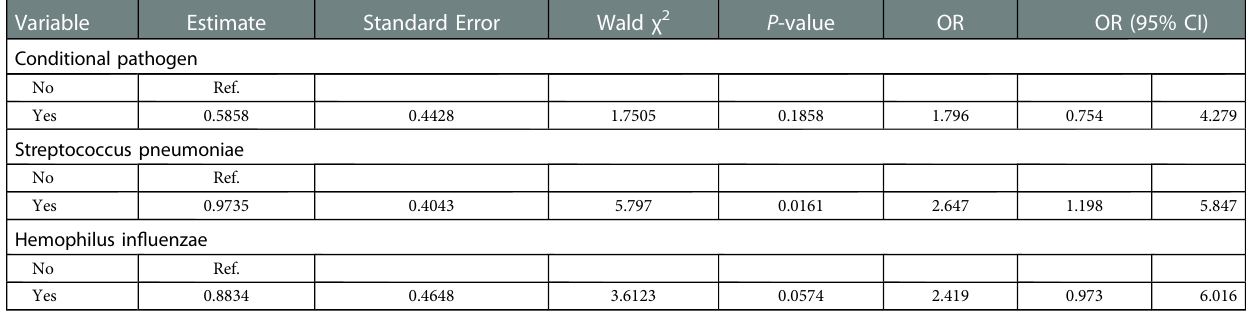
TABLE 4 Relationship between conditional pathogen culture and adenoid hypertrophy with otitis media with effusion (corrected for age and adenoid grade).